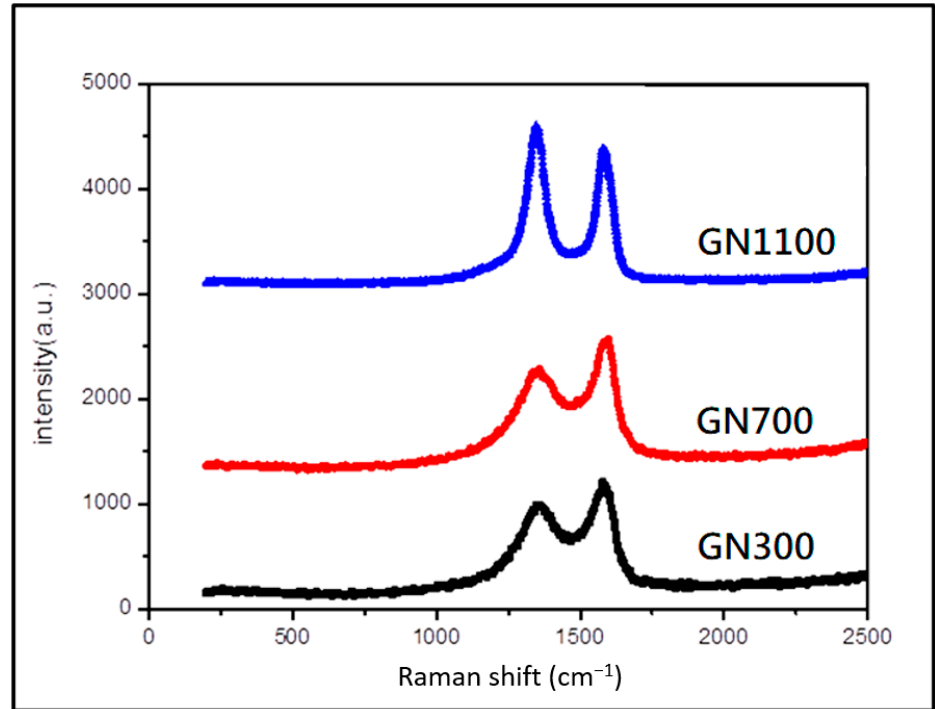
Figure 9. Raman spectra for GN reduced at various temperatures.